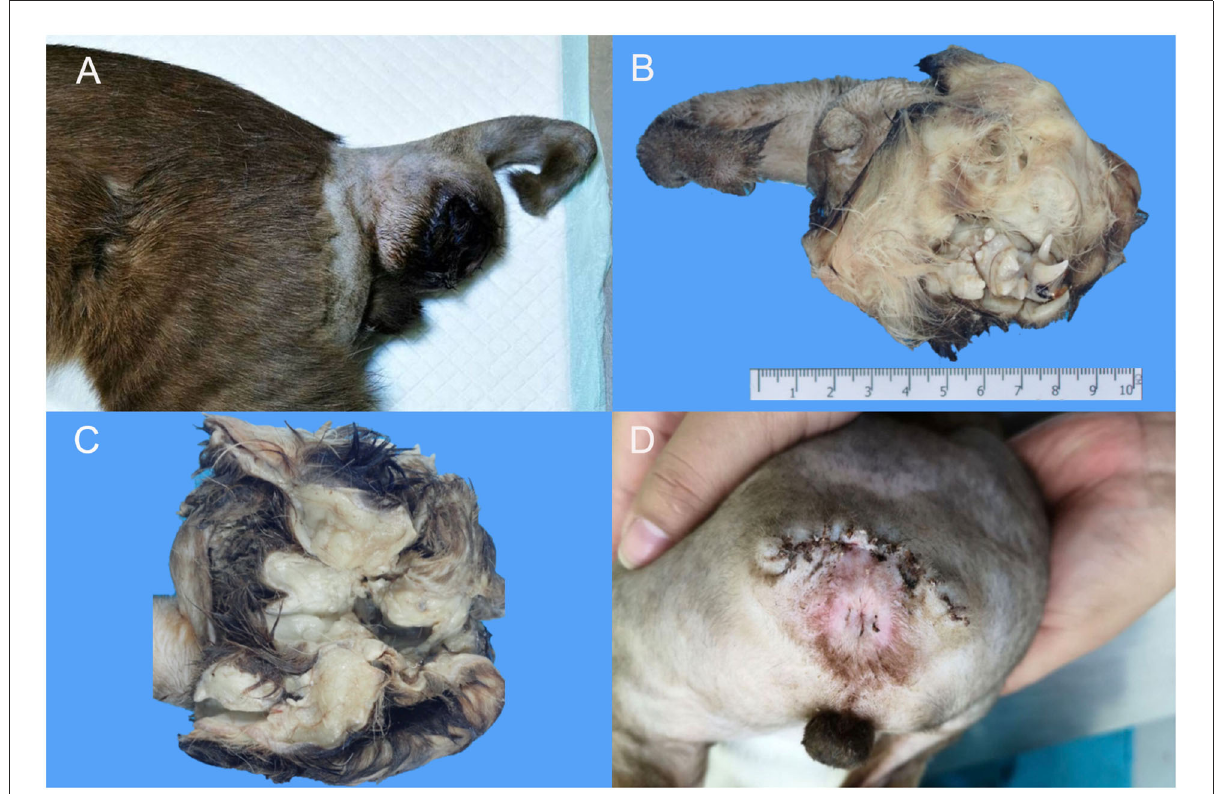
FIGURE1 Macroscopic findings of extragonadal teratoma at 1st − 8th caudal vertebrae in a male kitten. (A) A firm, well-circumscribed mass with size ∼ 4.8 × 8.5 × 4.5cm was located at the ventral part of the caudal vertebrae. (B,C) The cross section of the mass revealed hairs, teeth and multiple cystic structures. (D) The surgical wound after suture